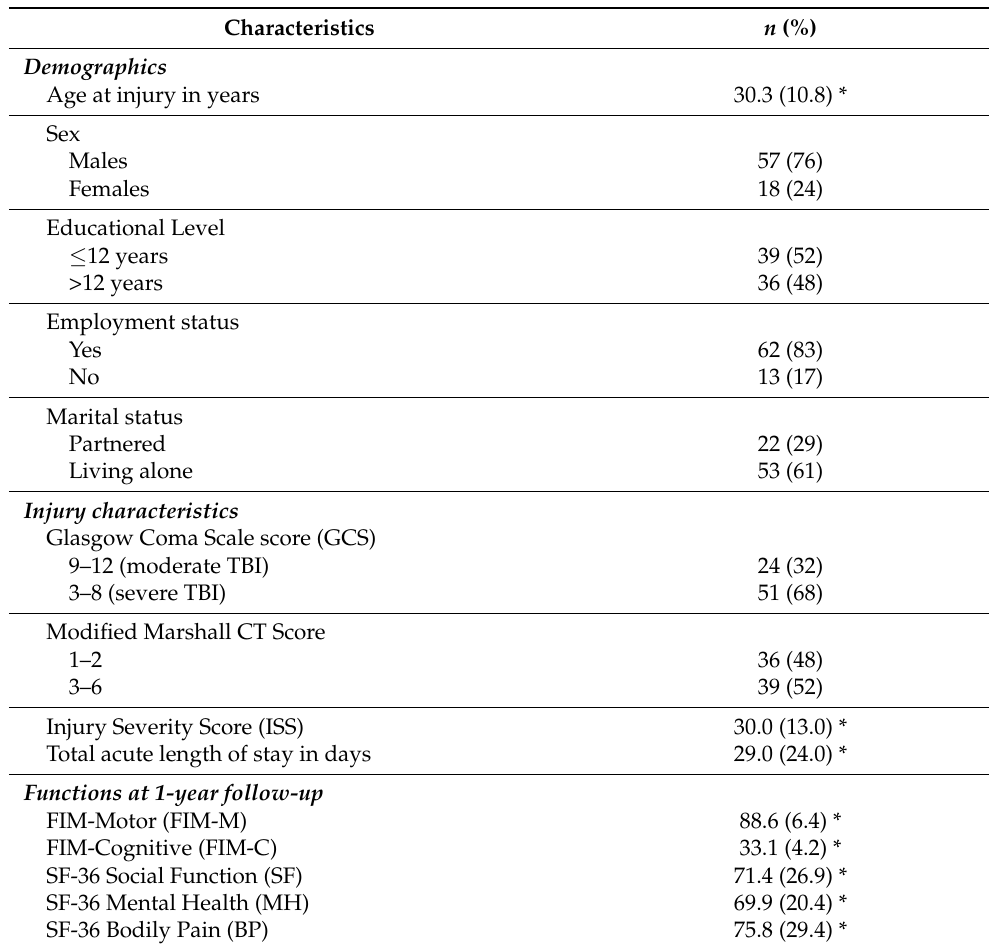
Table 1. Participants’ demographic and injury characteristics at baseline and functional status at 1-year follow-up ( n =